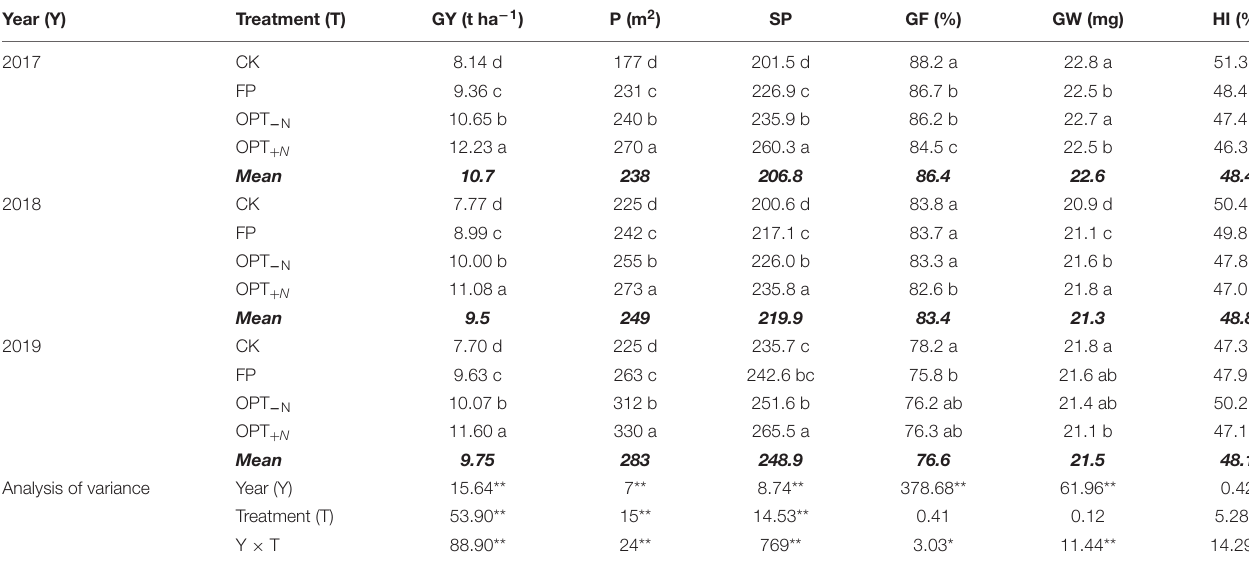
TABLE 3 | Yield and yield components from 2017, 2018, and 2019 in